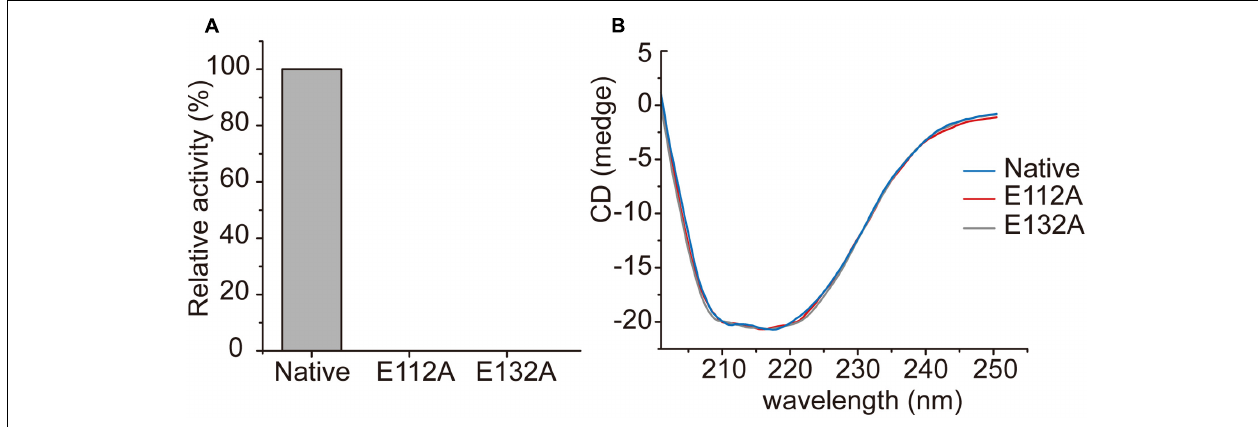
FIGURE 6 | Characterization of Rd AcuH mutants. (A) The relative activity of Rd AcuH and its mutants. The activity of the wild type Rd AcuH was taken as 100%. No activity was detected for neither Glu112 mutant nor Glu132 mutant. (B) CD spectra of Rd AcuH and its mutants. The spectral curves of Glu112 mutant, Glu132 mutant and wild type Rd AcuH are almost identical, indicating that their secondary structures have little change.